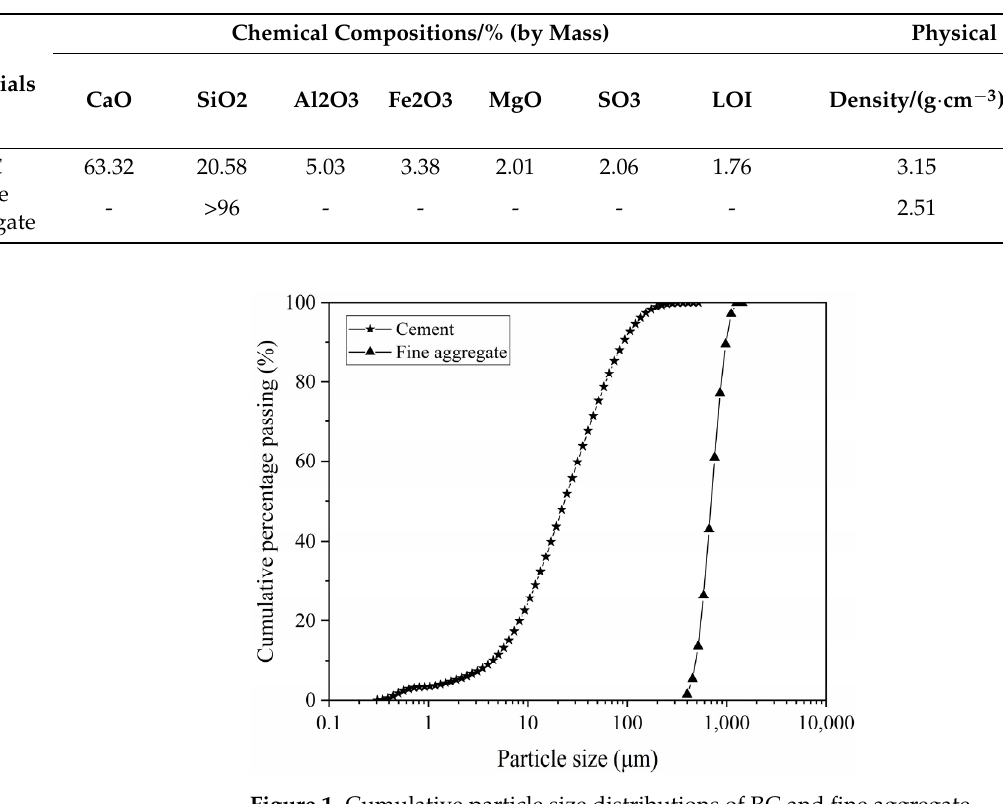
Figure 1. Cumulative particle size distributions of RC and fine aggregate.